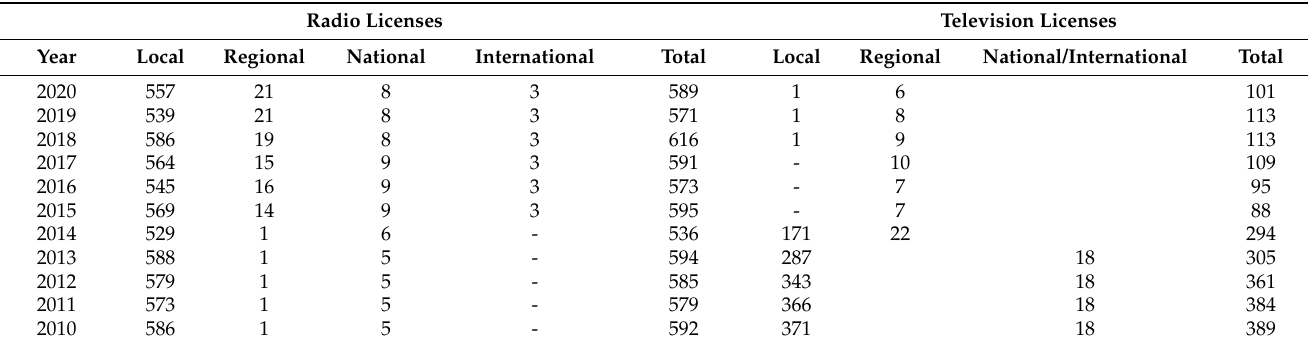
Table 2. Licensing for broadcasting and audiovisual services (terrestrial and